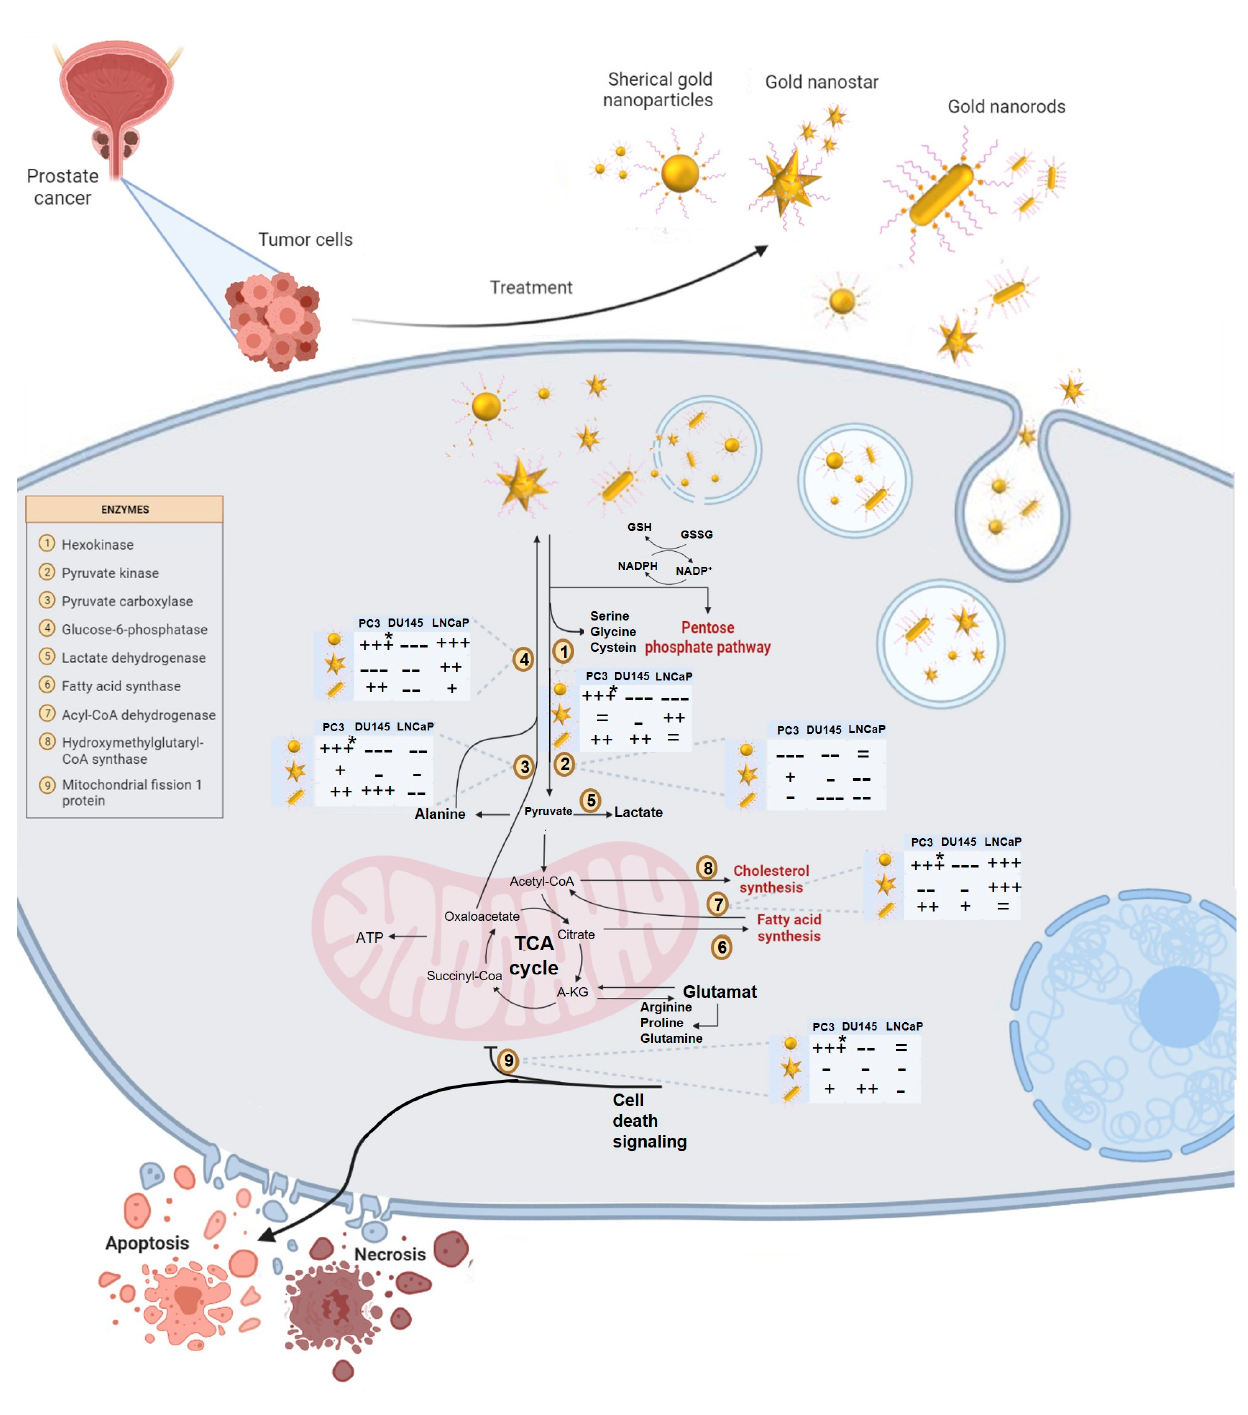
Figure 8. Effect of different types of gold nanoparticles (AuNPs) in several prostate cancer cell met- abolic pathways, including glycolysis, gluconeogenesis, and beta-oxidation after internalization. Prostate cancer cells exhibit increased lipid metabolism, which results in citrate synthesis at the tri- carboxylic acid (TCA) cycle that is not only an energy source but also for other biomolecules syn-